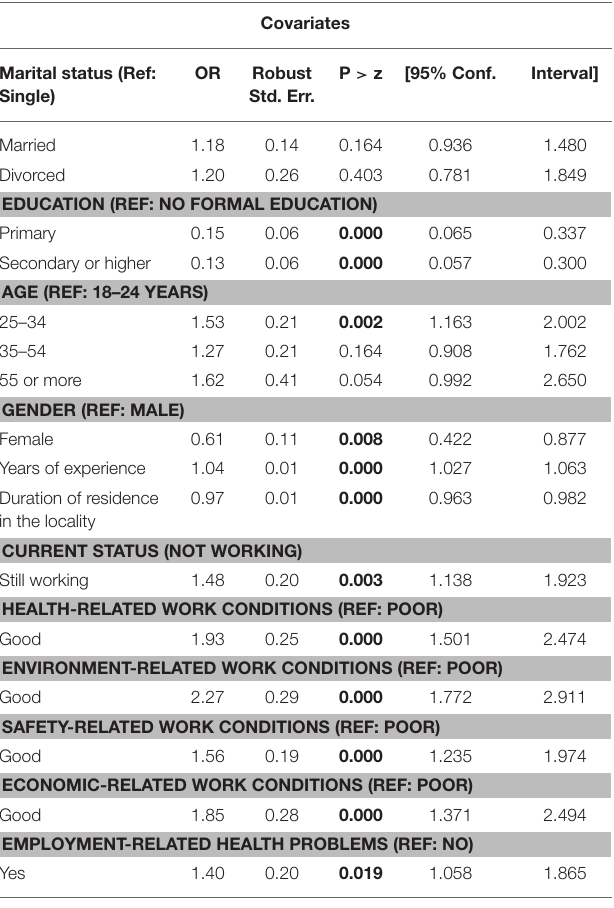
TABLE 4 | Zero-order relationships between artisanal and small-scale gold miners knowledge of health effects of mercury use and theoretically-relevant factors ( n = 588